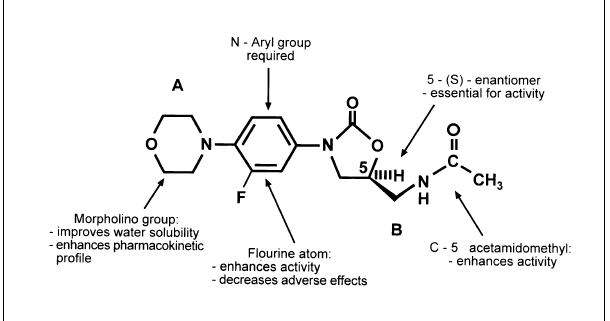
Figure 2) Structure activity relationships of linezolid